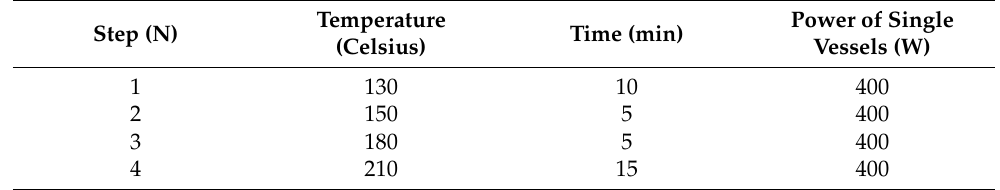
Table 1. Properties of time, temperature, and power used for digestion of samples by a digester device